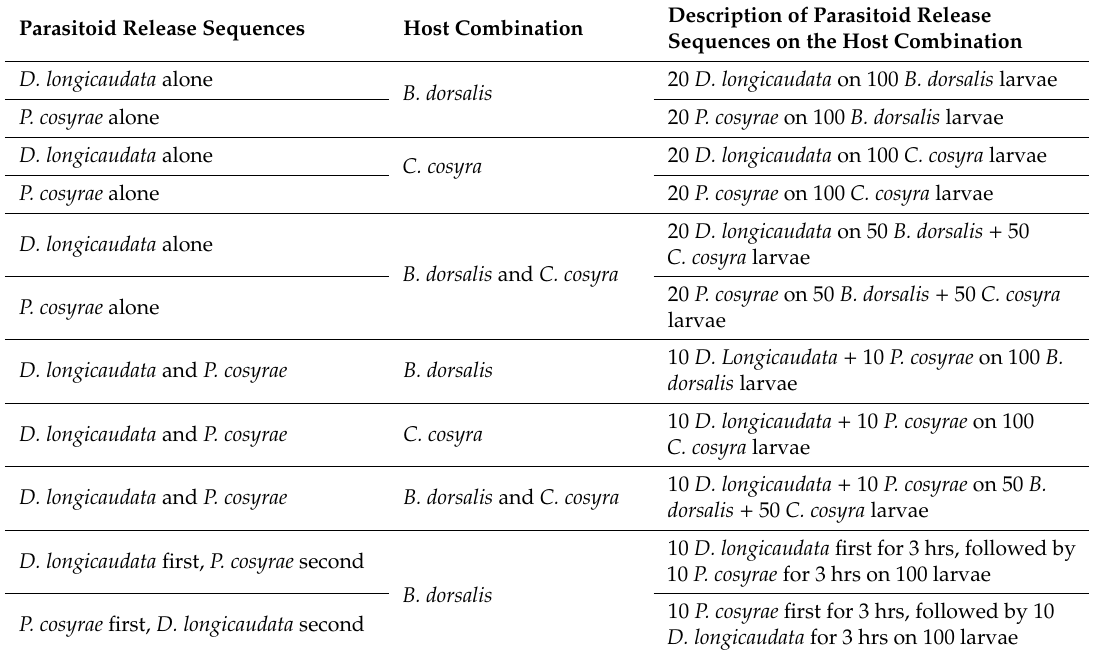
Table 1. Diachasmimorpha longicaudata and Psyttalia cosyrae release strategies, sequences, and densities on two fruit fly hosts Bactrocera dorsalis and Ceratitis cosyra under laboratory